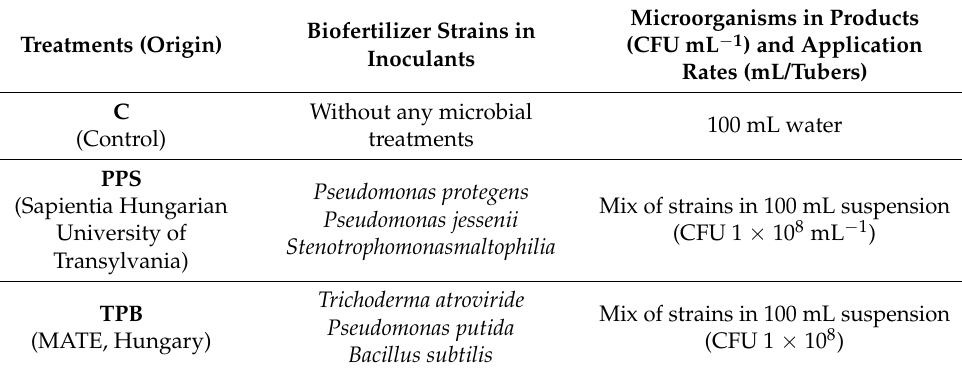
Table 3. Treatments and the microorganism species content of the two inoculant mixtures used in the potato field experiment. Microorganisms in Biofertilizer Strains in Treatments (Origin) Inoculants